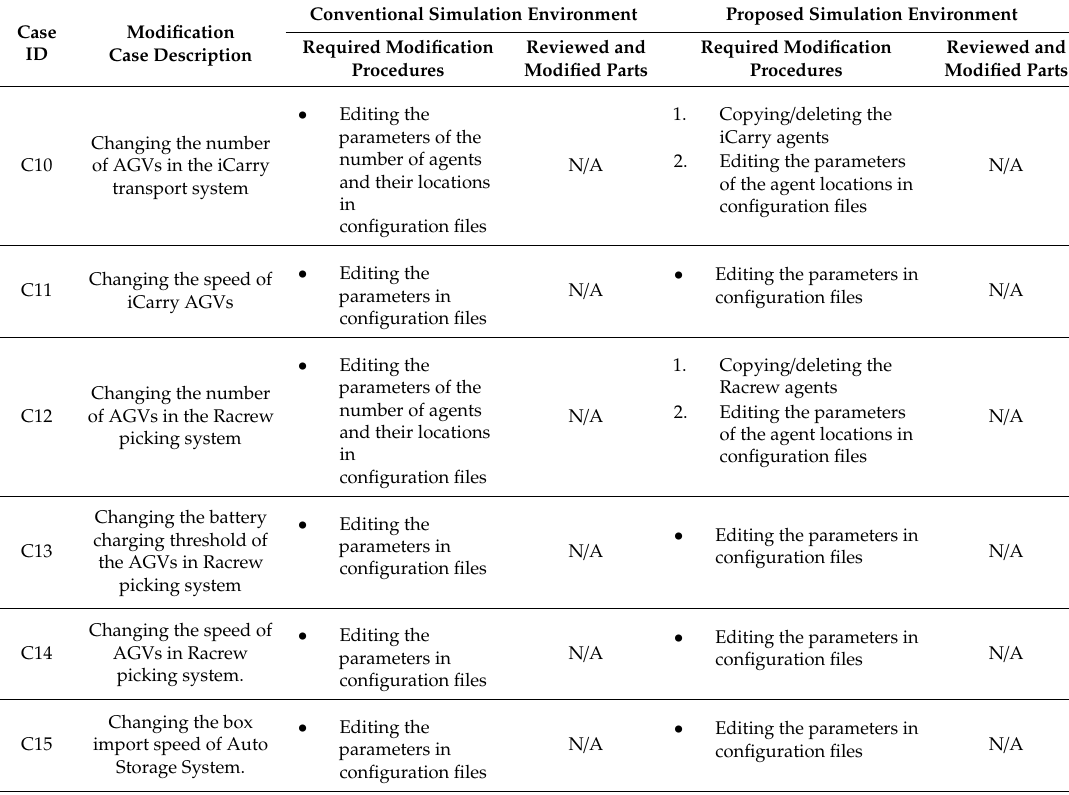
Table A2. Modification cost evaluations on modification cases of agent